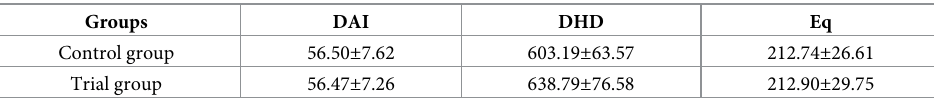
Table 3. Concentration (ng/ml) of daidzein and its metabolites in rat